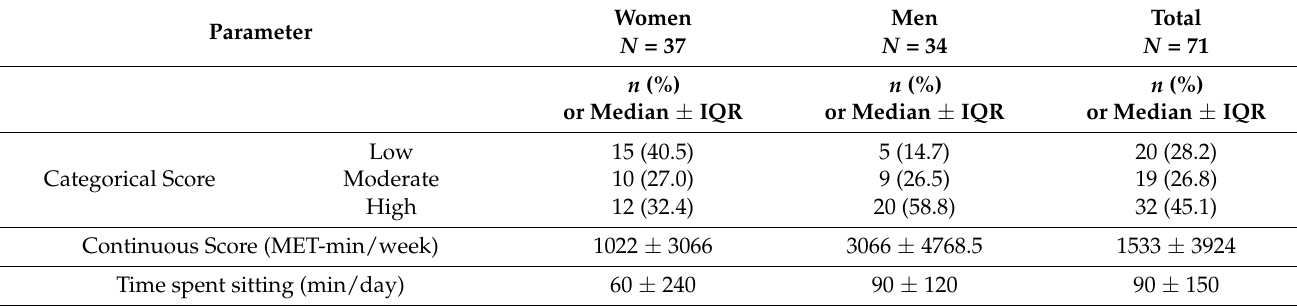
MedDietScore (range 0–55)